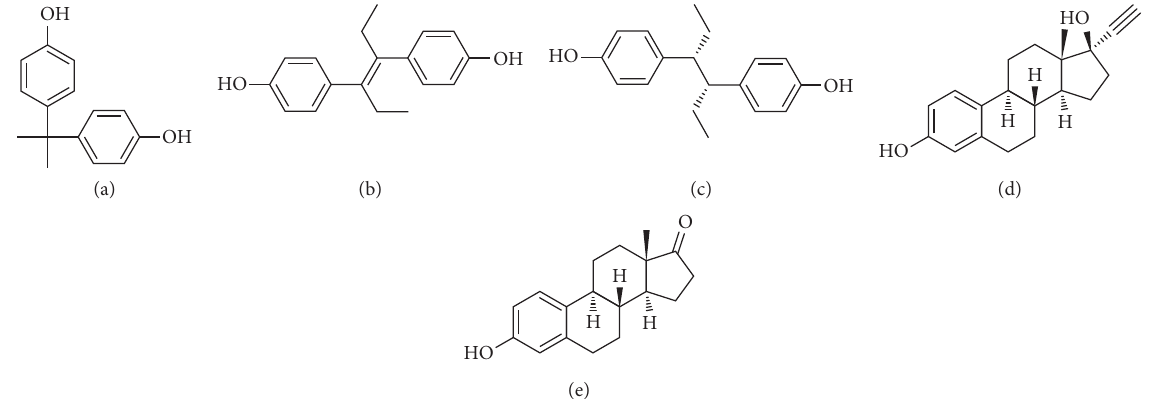
Figure 1: Chemical structures of natural and synthetic estrogens used in this study. (a) Bisphenol A. (b) Diethylstilbestrol. (c) Hexestrol. (d) Ethinyl estradiol. (e) Estrone.